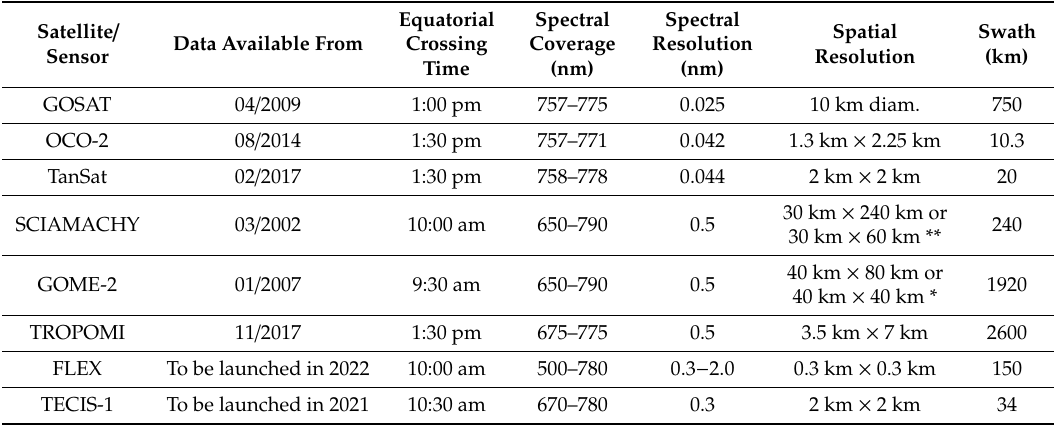
Table 1. Technical characteristics of current satellites / instruments with the ability to provide global solar-induced chlorophyll fluorescence (SIF) retrievals as well as the planned Terrestrial Ecosystem Carbon Inventory Satellite (TECIS-1) and FLuorescence EXplorer